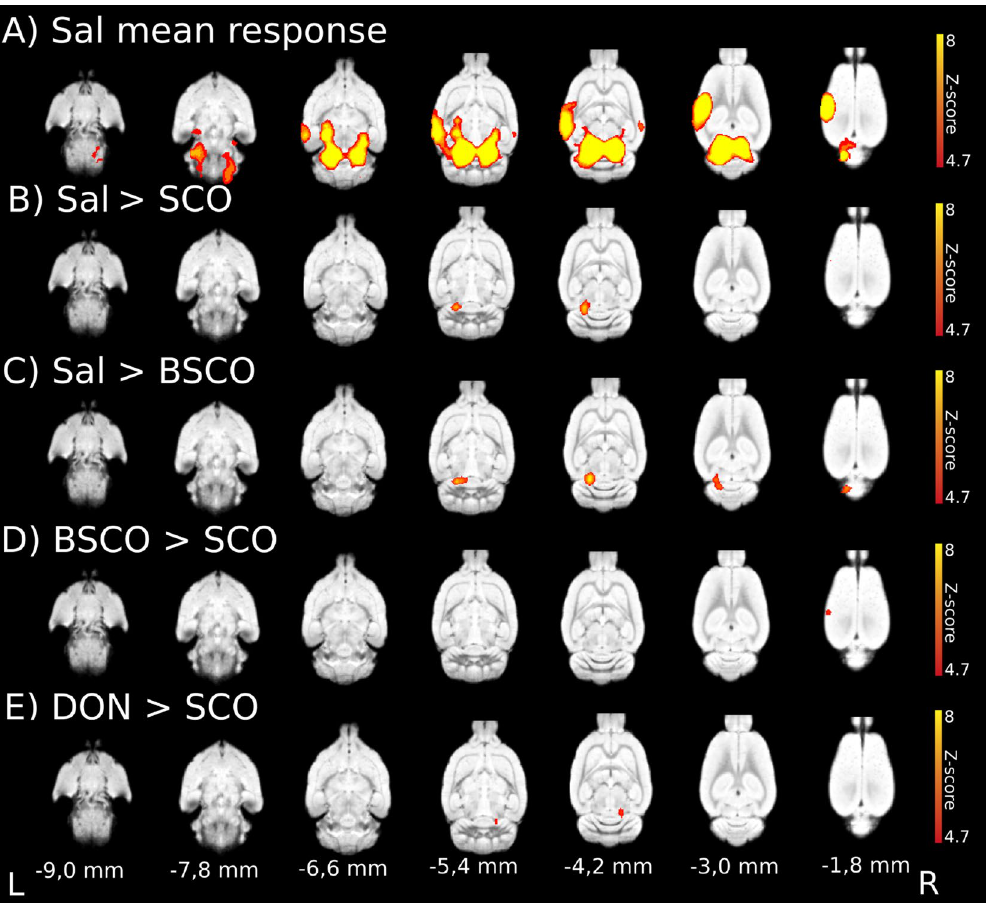
Figure 3. Whisker stimulation evoked BOLD response and evoked BOLD response differences between treatment groups with GE EPI sequence in medetomidine-isoflurane combined anesthesia (n = 62; 15, 16, 16, 15 of Sal, SCO, BSCO, DON, respectively). ( A ) Mean activation response evoked by whisker sensory stimulation in the saline (Sal) group. ( B ) Sal > SCO contrast. ( C ) Sal > BSCO contrast. ( D ) BSCO > SCO contrast. ( E ) DON > SCO contrast. Decreased BOLD responses in the BC due to SCO ( B , D ) and in the IC due to both SCO and BSCO ( B , C ). Increased BOLD responses in the right IC in the DON treatment group compared to the SCO group ( E ). The Z-scores represent probabilistic TFCE (pTFCE) statistics (p < 0.05 correcting for multiple comparisons via GRF theory based FWER, red-to-yellow z = 4.7 to z = 8) . The corresponding colorbars are depicted on the right. The z coordinates (distance from Bregma) of the selected slices (− 9.0 mm; − 1.8 mm) are given at the bottom of the figure (L and R stand for